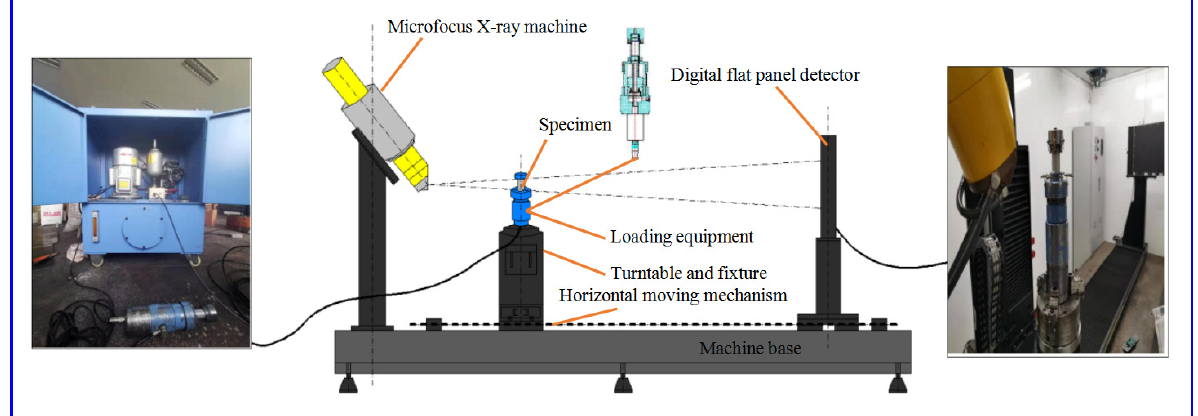
Figure 1. CT platform experimental system.